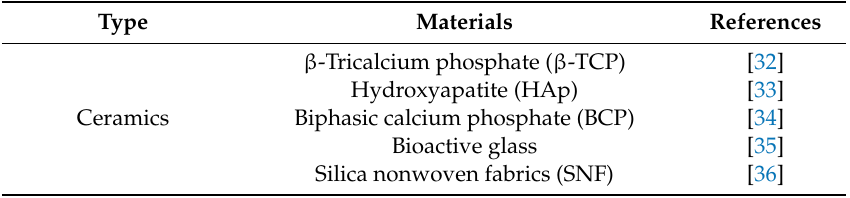
Table 2. Representative sca ff olds for bone tissue regeneration using